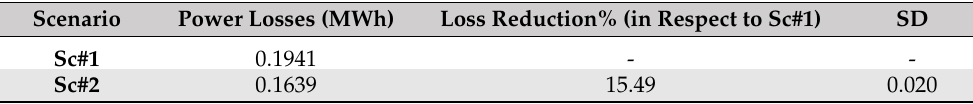
Figure 8. Boxplots of voltage values of all nodes within the examined time period for ( a ) Sc#1 and ( b ) Sc#2. Finally, Figure 9 presents the hourly total power demand of the LV DNs for each scenario, as well as the average demand. From Figure 9, we can conclude that the unco- ordinated charging of EVs leads to charging overlaps and therefore to power demand increase at certain hours. In addition, the employment of the proposed charging planning of EVs can result to a smoother load curve, by minimizing the peaks and filling the val-